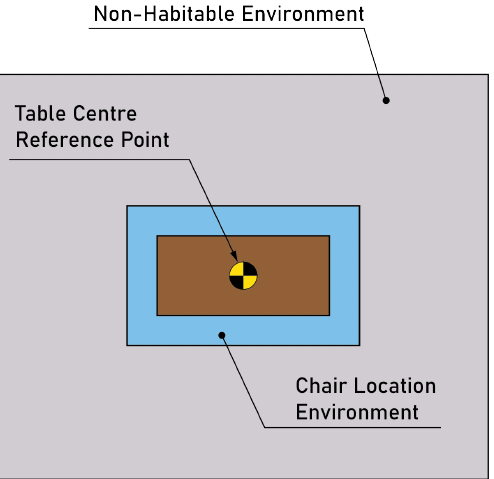
Figure 1. Table Definition for the hostelry perspective. The CLE and NHE dimensions are known and can be referenced from the Table centre, the reference point for the MA optimisation proposed.